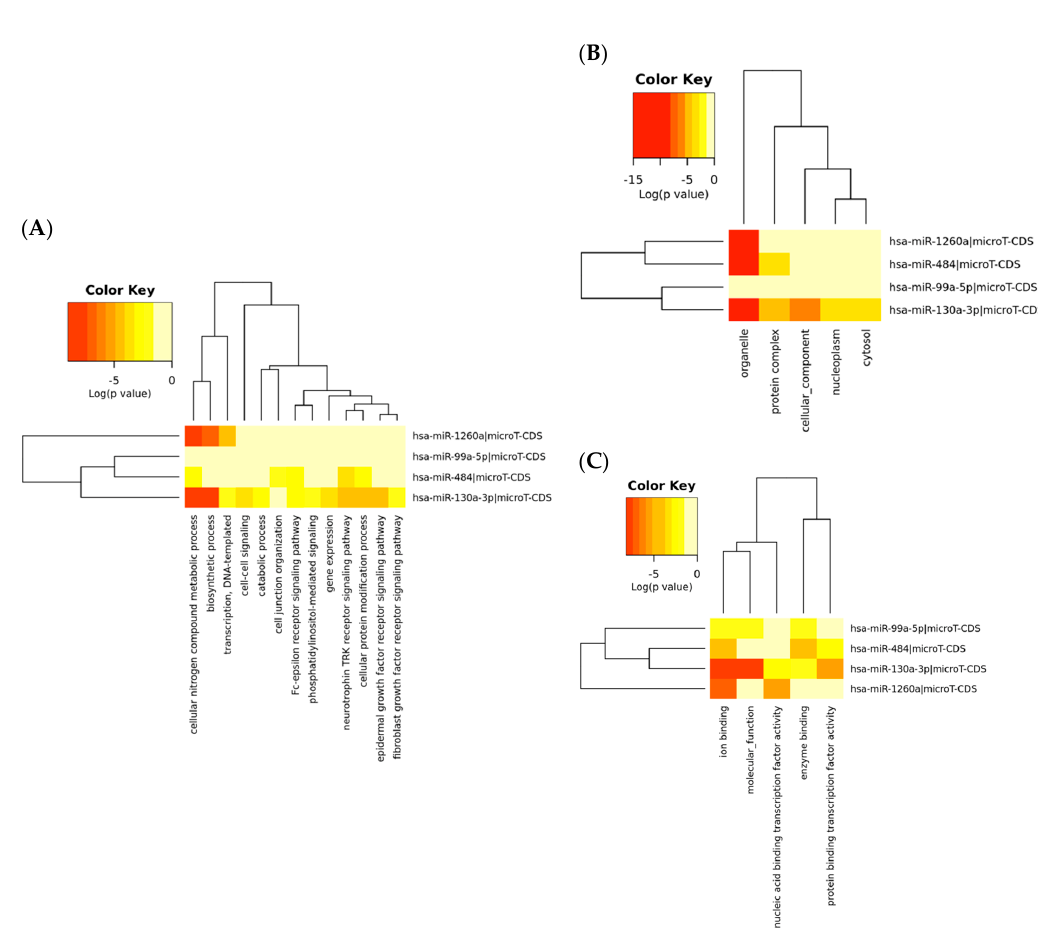
Figure 2. Heatmaps of the Gene Ontology (GO) analysis. GO enrichment of putative targets was performed for four significantly up-regulated miRNAs at three levels: ( A ) biological process, ( B ) cellular component and ( C ) molecular function. Different colours represent different levels of pathway term enrichment in the miRNA target genes. Red indicates a higher degree of enrichment.